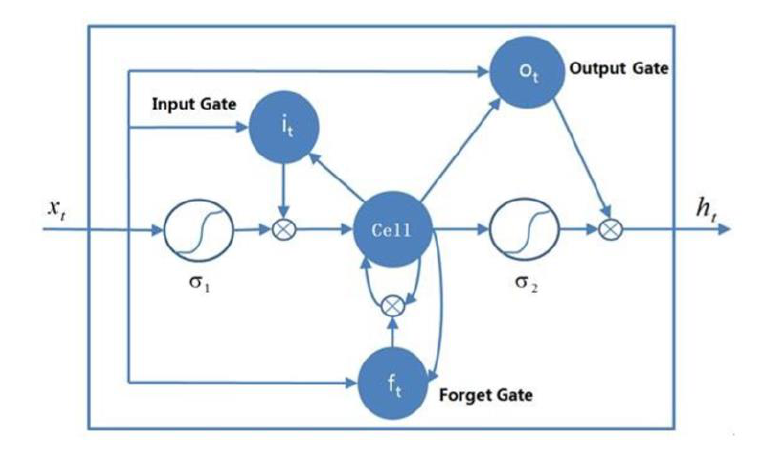
Figure 1. Memory cell